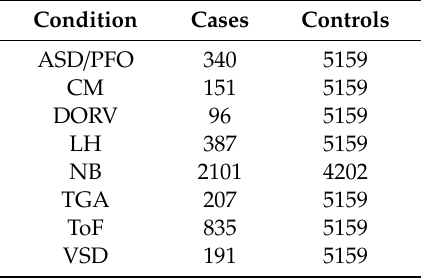
Table 1. Data sets used in this